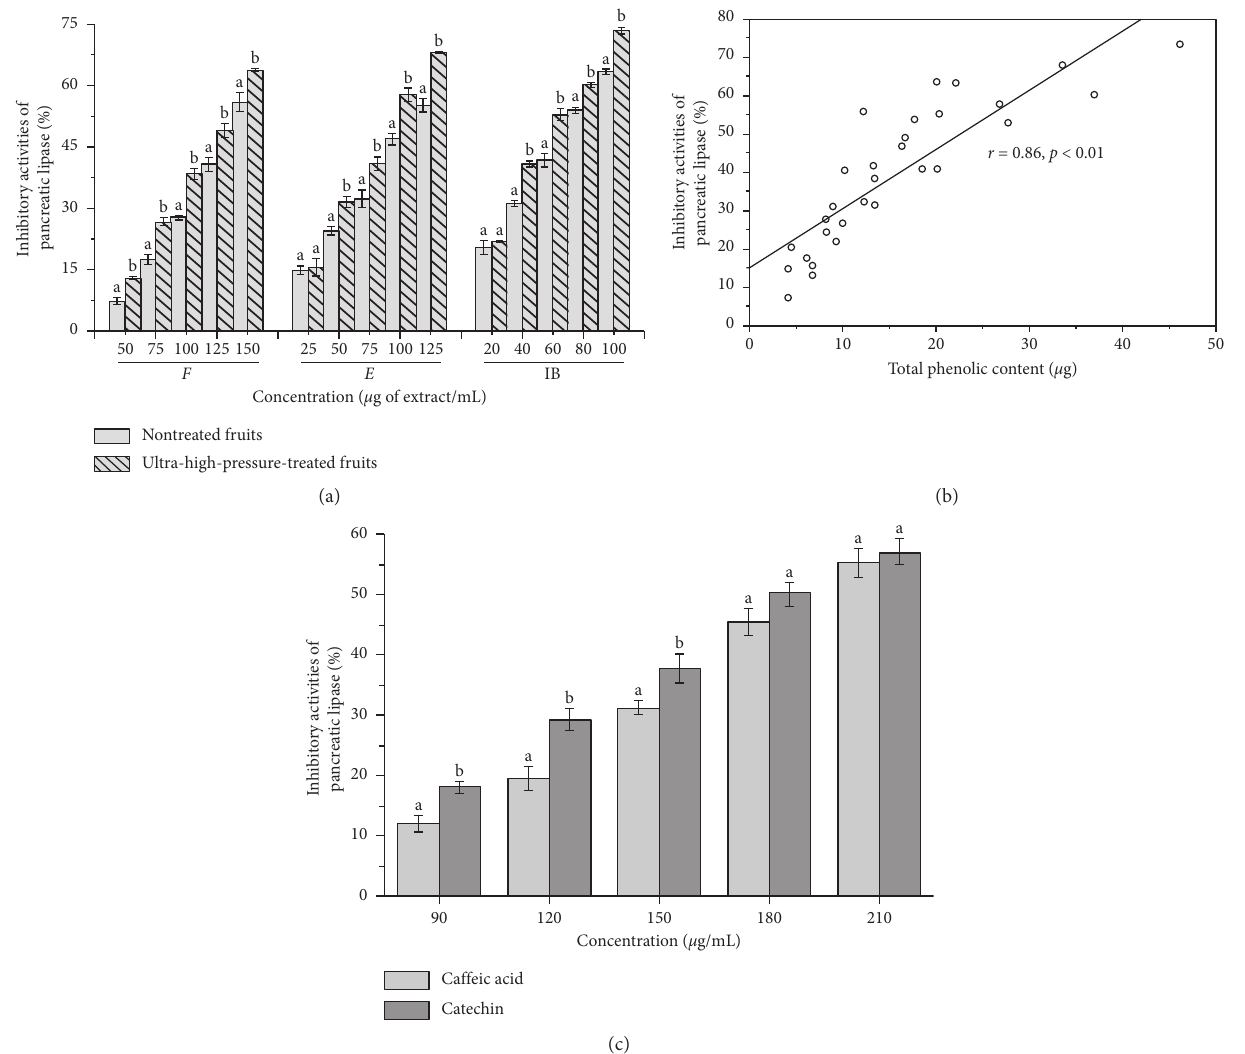
Figure 1: (a) The lipase inhibitory effects of free, esterified and insoluble-bound phenolic fractions from nontreated and ultra-high- pressure-treated oil palm fruits. (b) The correlation analysis of TPC and pancreatic lipase inhibitory effects. (c) Two main phenolic compound standards (catechin and caffeic acid). “ F ”: free phenolic fraction; “ E ”: esterified phenolic fraction; “IB”: insoluble-bound phenolic